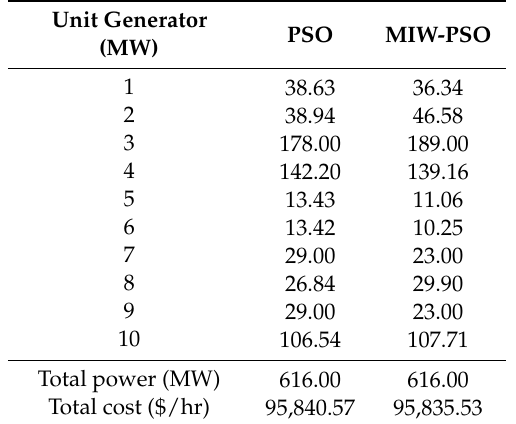
Table 14. Simulation result comparison on the fifth case study.